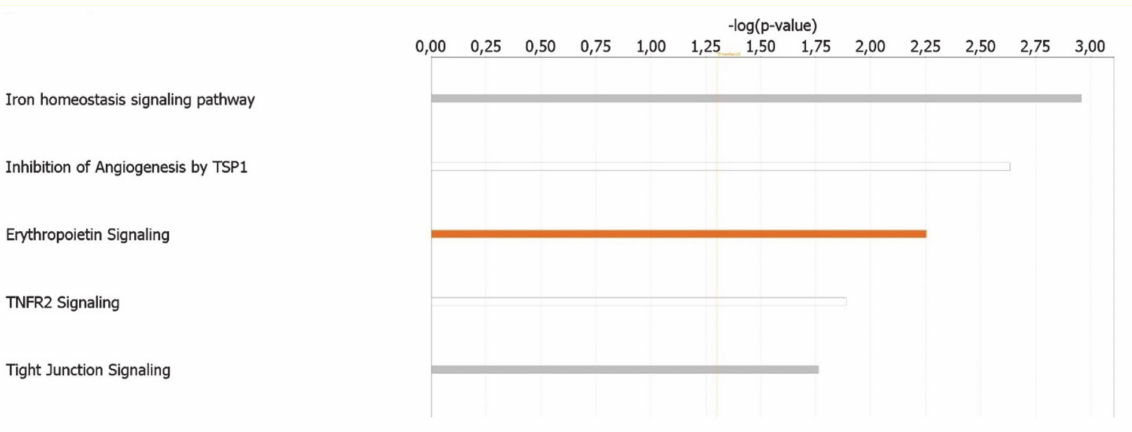
Figure 3. Ingenuity Pathway Analysis: Illustrated are the top canonical pathways most significantly associated with differentially expressed genes in MKD patients. The color of the bars refers to the prediction of activation (orange bars) or inhibition (blue bars) based on the z score. The bars are grey if the prediction cannot be assessed and white when z =